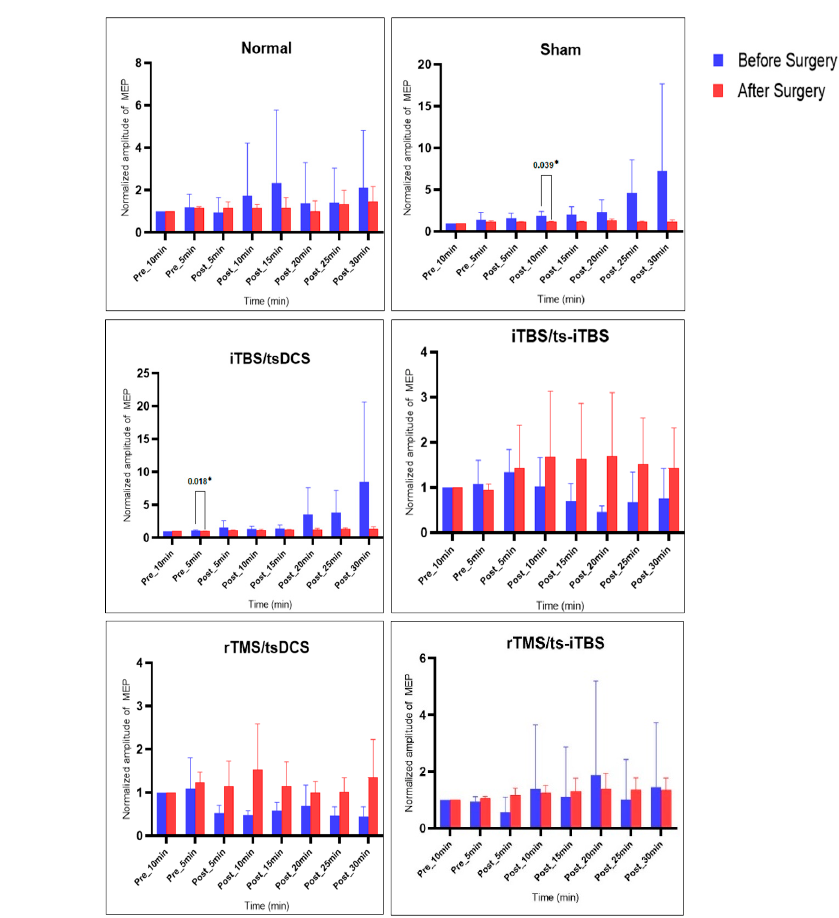
Figure 7. Before Surgery, MEP values before SCI surgery; After Surgery, MEP values after surgery and four ‐ week stimulation intervention. Paired sample t ‐ test was used for comparison of before vs. after surgery and stimulation intervention; the level of significance was set to p < 0.050 *. The MEP values before surgery in pre_5 min vs. after surgery and four ‐ week stimu ‐ lation in post_5–30 min changed without reaching the level of significance. The 3 min iTBS/tsDCS group had significantly changed MEP values after the four ‐ week intervention in post_10 min ( p = 0.003 *) and post_15 min ( p = 0.002 *), with an increasing trend (Table 2). Table 2. MEP of both sides before vs. after surgery and stimulation intervention at different time points ( n = 24). Groups